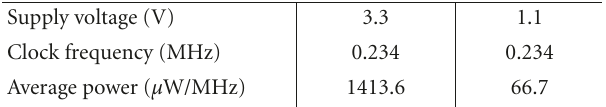
Table 6: CBT processor power dissipation simulation results under 1.1 V and